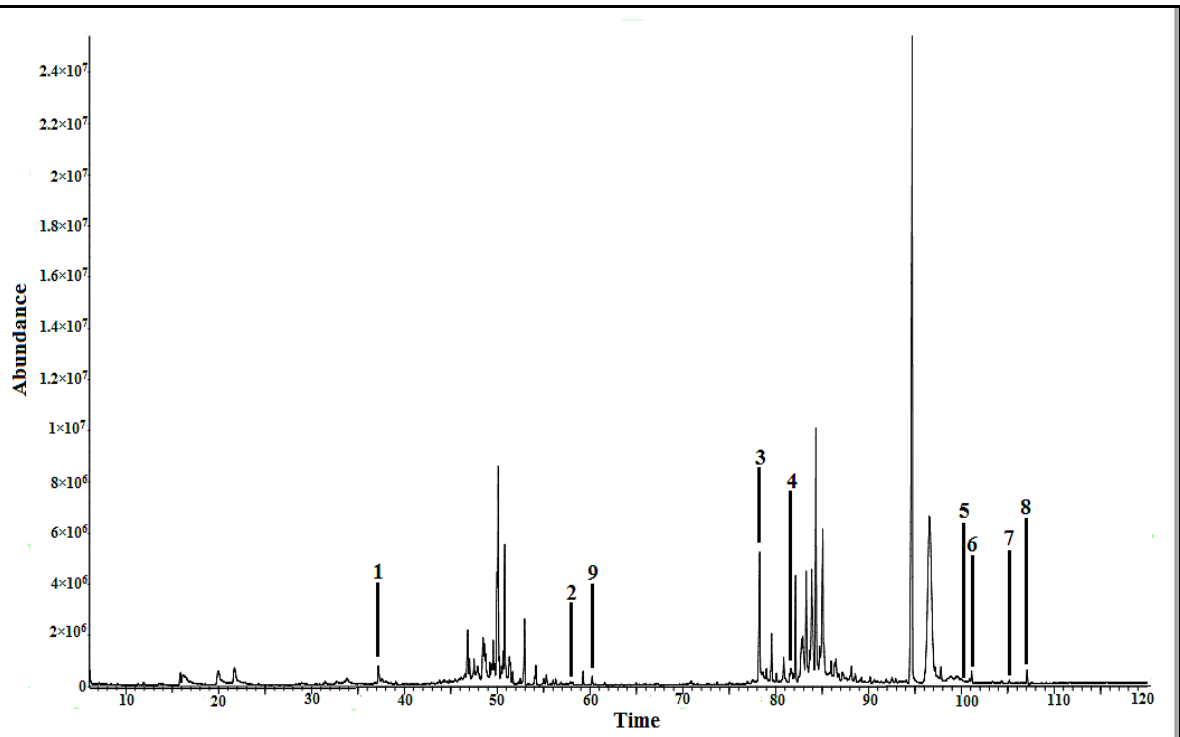
Table 2. Putative metabolites detected by GC-MS analysis.